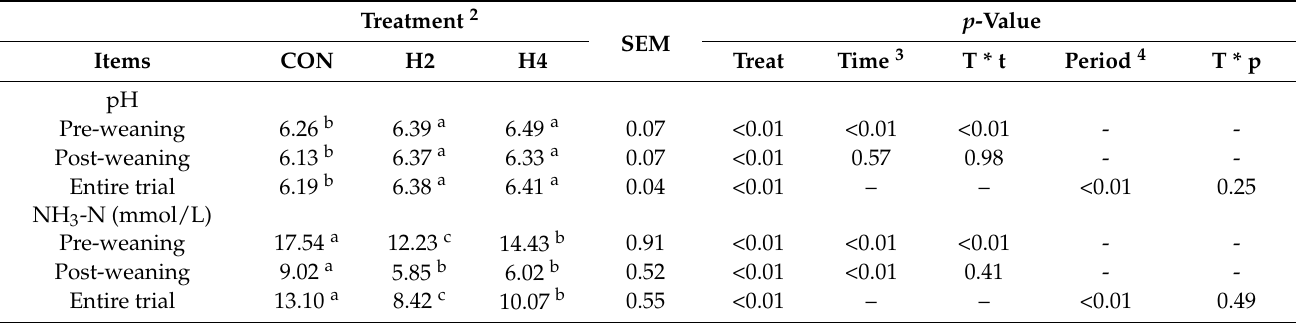
Table 5. Effects of hay supplementation at different ages on rumen pH and NH 3 -N in dairy calves during different periods 1